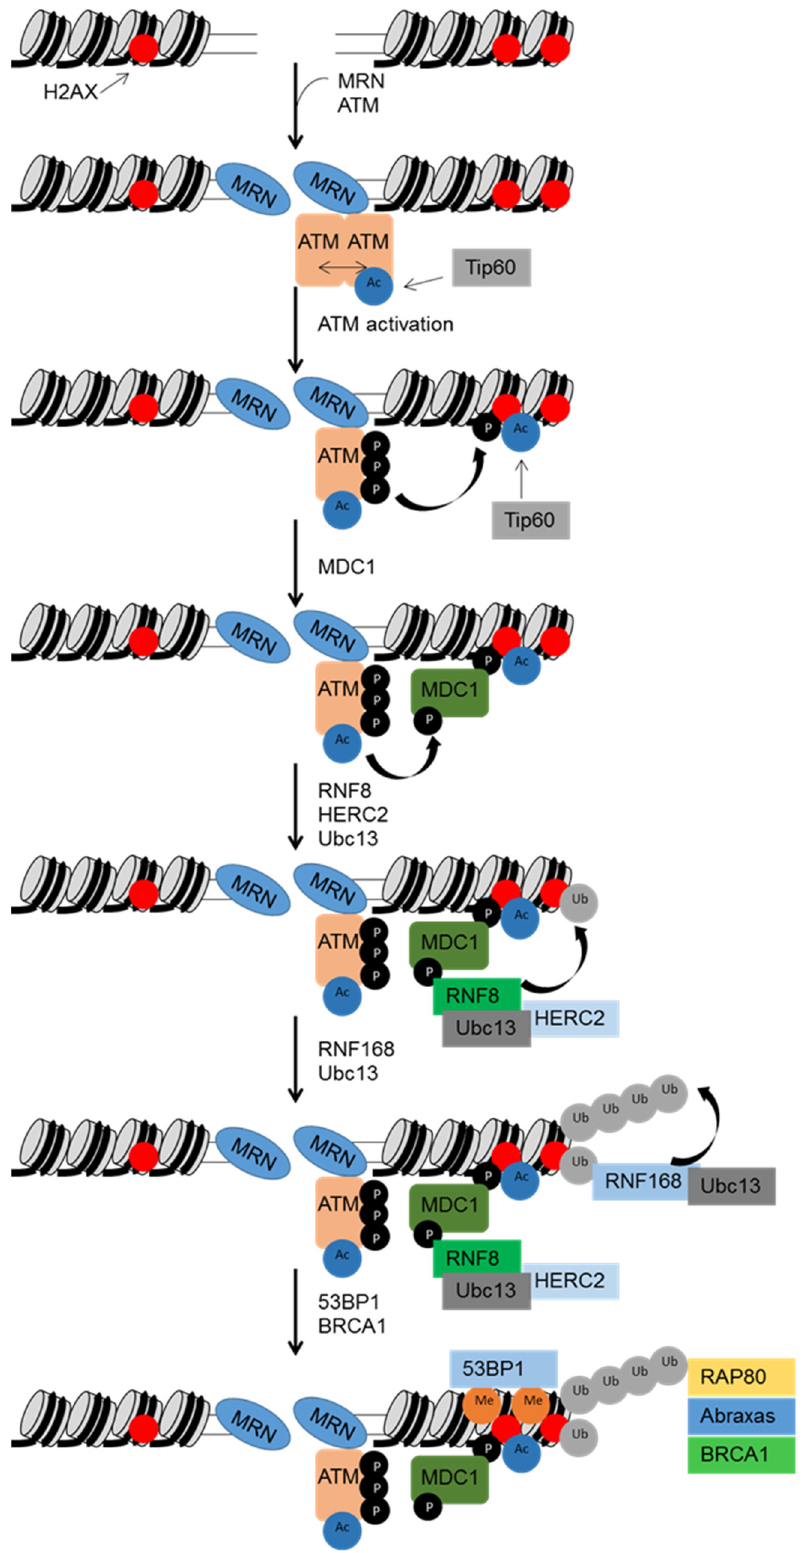
Figure 1. ATM activation in response to DSBs. The MRN complex rapidly migrates to sites of DSBs and, along with the acetyltransferase Tip60, contributes to activation of ATM kinase activity. Phosphorylation of histone H2AX by ATM results in binding of MDC1 which subsequently mediates recruitment of factors, such as 53BP1 and BRCA1, which participate in DSB repair and regulation of cell cycle